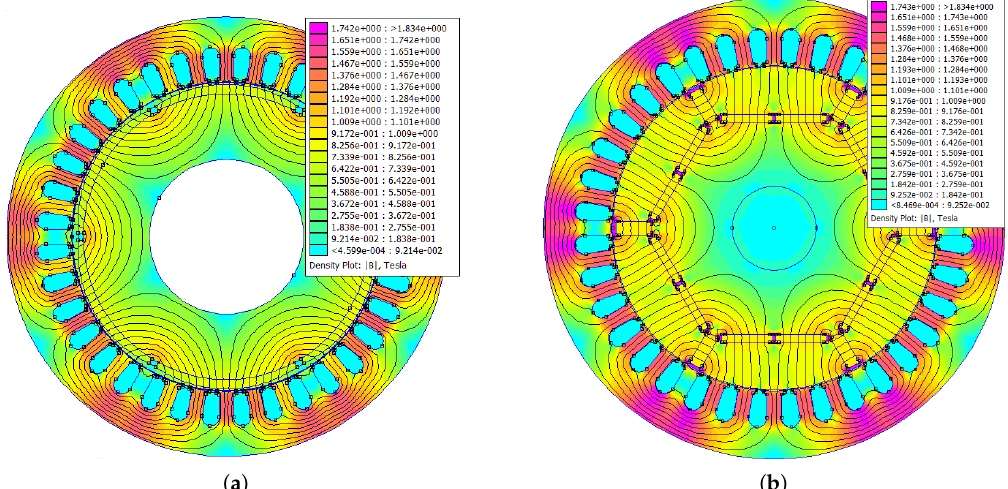
Figure 3. Flux density distribution from 0.84 mT to 1.83 T at no load of: ( a ) reference surface permanent-magnet synchronous machine; ( b ) Proposed Interior Permanent-Magnet Synchronous Machine.